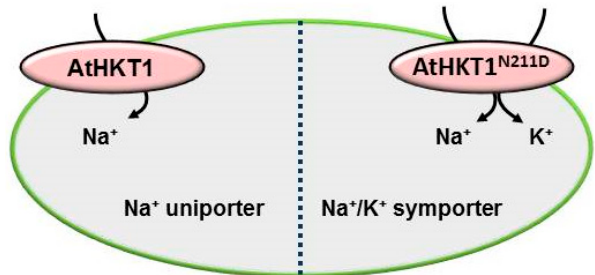
Figure 5. Functional properties of AtHKT1 and AtHKT1 N211D and differential selectivity for Na + and K + based on the Asn/Asp variance in the pore region. Wild type AtHKT1 is a sodium uniporter and does not confer salt stress tolerance. An altered version of AtHKT1 with a mutation of the Asn to Asp (AtHKT1 N211D ) is also able to uptake potassium and confers salt stress tolerance. It has already been shown by Ali et al. 2016 that athkt1-1 plants complemented by AtHKT1 N211D showed higher tolerance to salt stress than lines complemented by the wild type AtHKT1 . Thus, the introduction of Asp, replacing Asn, in HKT1-type transporters established altered cation selectivity and uptake